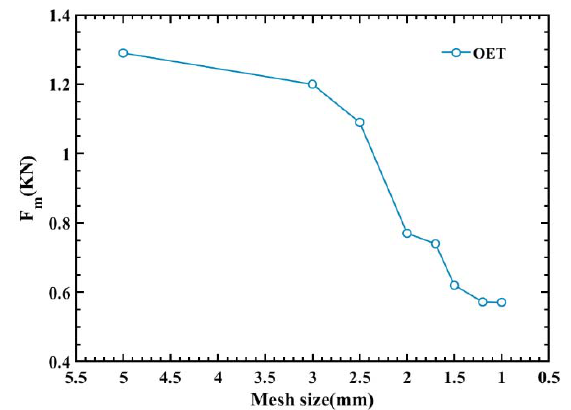
Figure 2. Mesh sensitivity test of the OET.